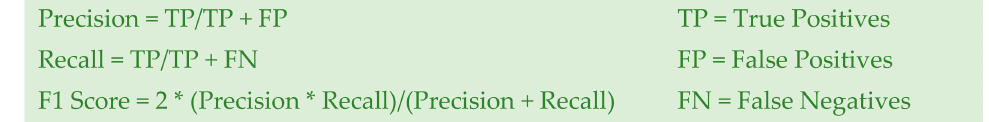
Figure 7. Performance metrics.